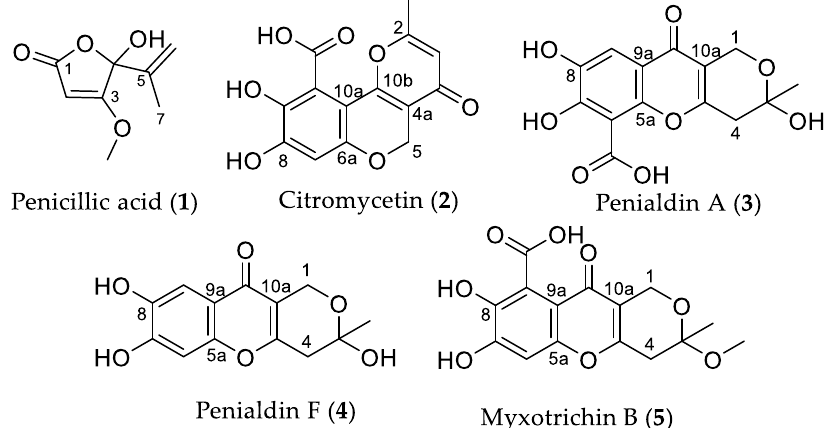
Figure 1. Structures of polyketide metabolites isolated from Penicillium.